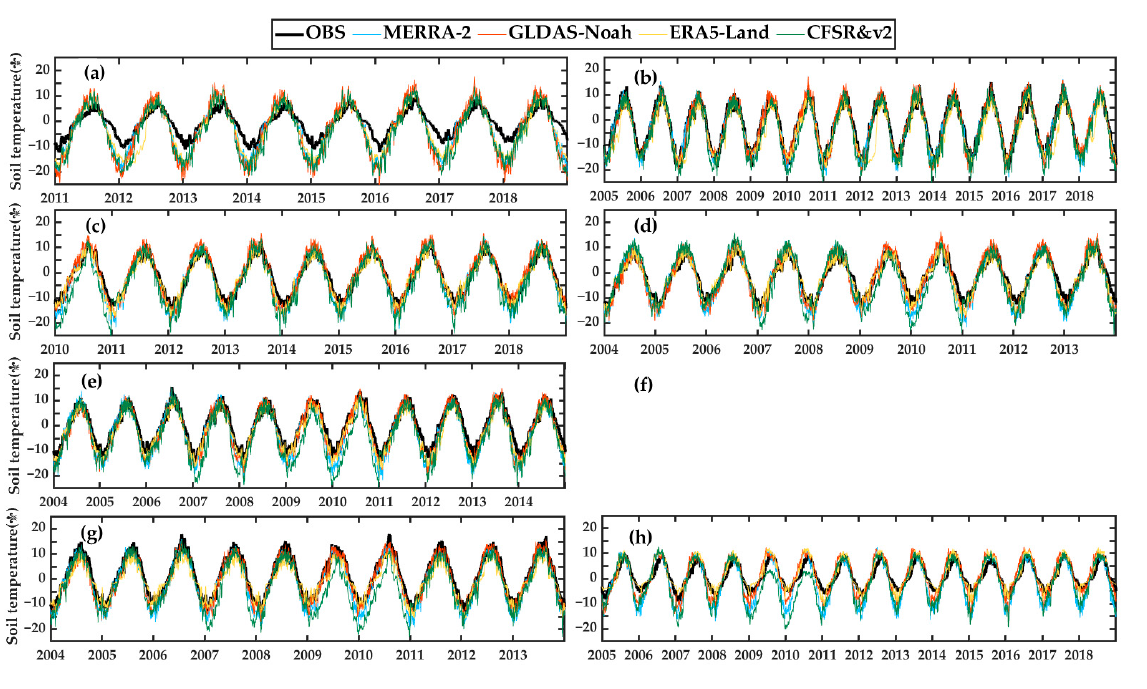
Figure 2. Comparison of the daily average of reanalysis soil temperature to in situ observed at a depth of 10 cm. OBS: observations data, ( a ) QT09, ( b ) Ch06, ( c ) QT08, ( d ) QT01, ( e ) QT03, ( f ) Ch01,